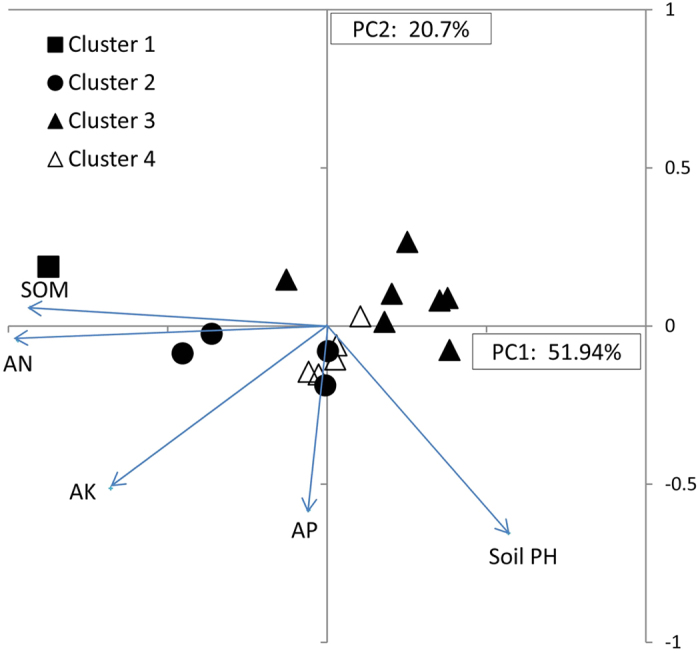
Principal components analysis of 17 soil samples of the adzuki bean production areas.Variable factor loadings for PC1 and PC2 are soil pH and soil nutrient variables and presented as vectors.